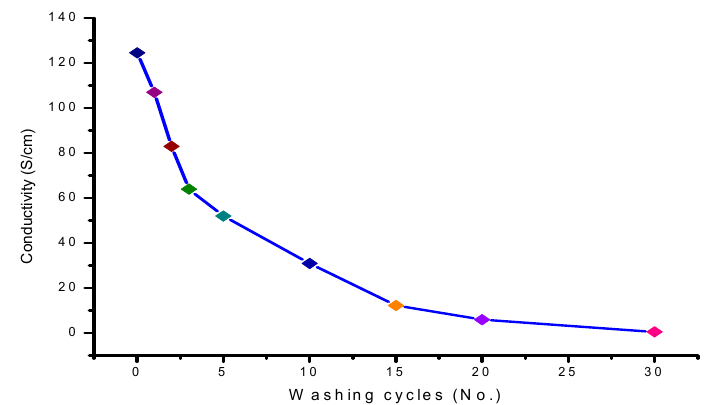
Figure 6. Wash durability of conductivity of charcoal-coated fabrics.